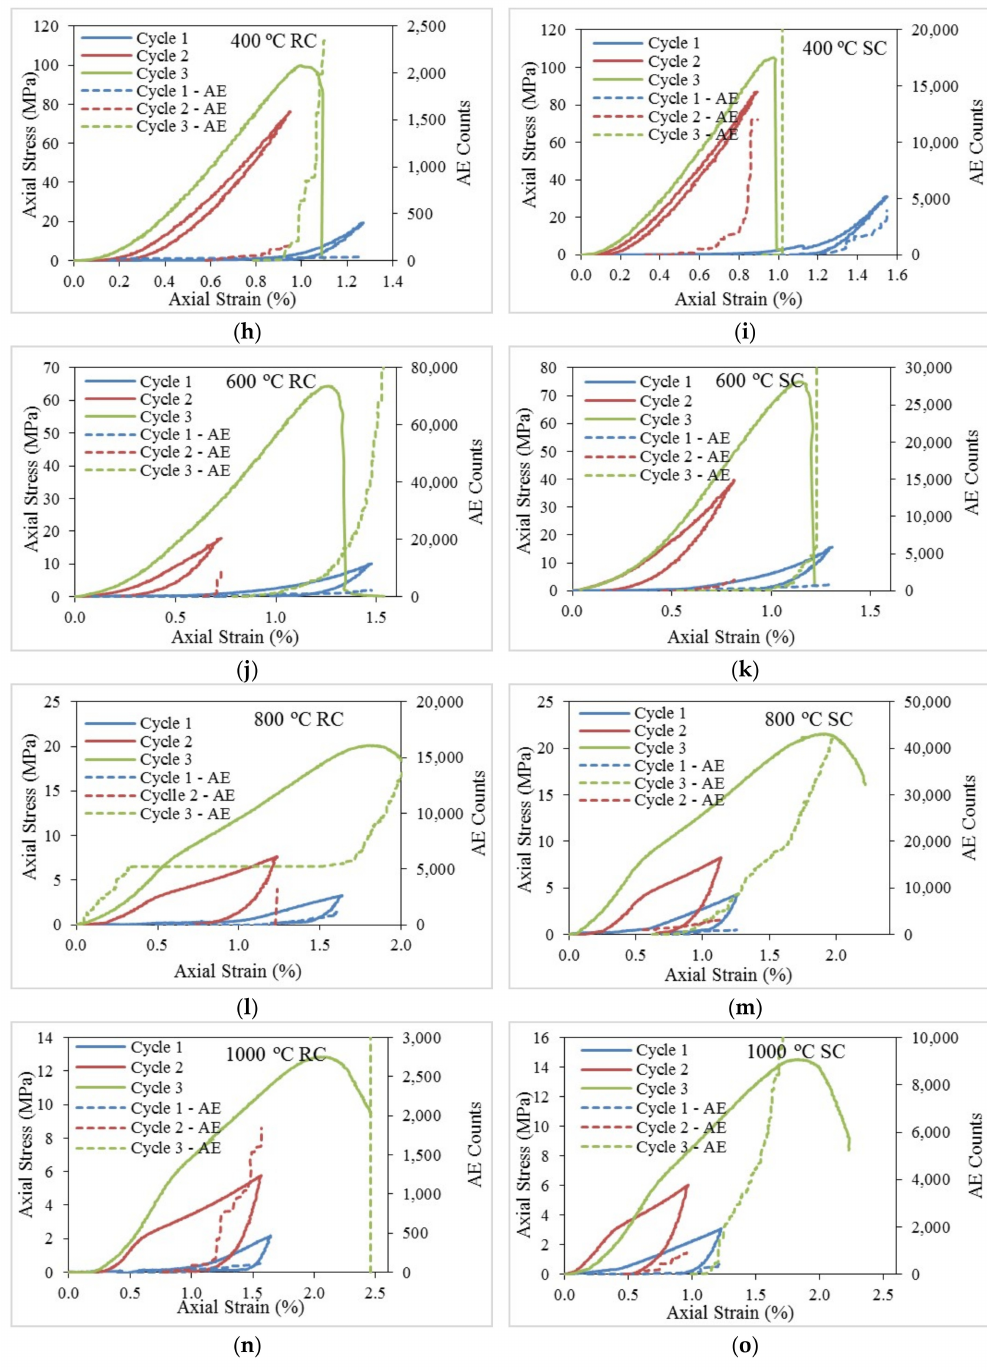
Figure 11. Stress-strain curves plotted with AE counts originated during loading and unloading cycles under each test condition, ( a ) 25 ◦ C; ( b ) 100 ◦ C RC; ( c ) 100 ◦ C SC; ( d ) 200 ◦ C RC; ( e ) 200 ◦ C SC; ( f ) 300 ◦ C RC; ( g ) 300 ◦ C SC; ( h ) 400 ◦ C RC; ( i ) 400 ◦ C SC; ( j ) 600 ◦ C RC; ( k ) 600 ◦ C SC; ( l ) 800 ◦ C RC; ( m ) 800 ◦ C SC; ( n ) 1000 ◦ C RC; ( o ) 1000 ◦ C SC where RC denotes rapid cooling and SC denotes slow